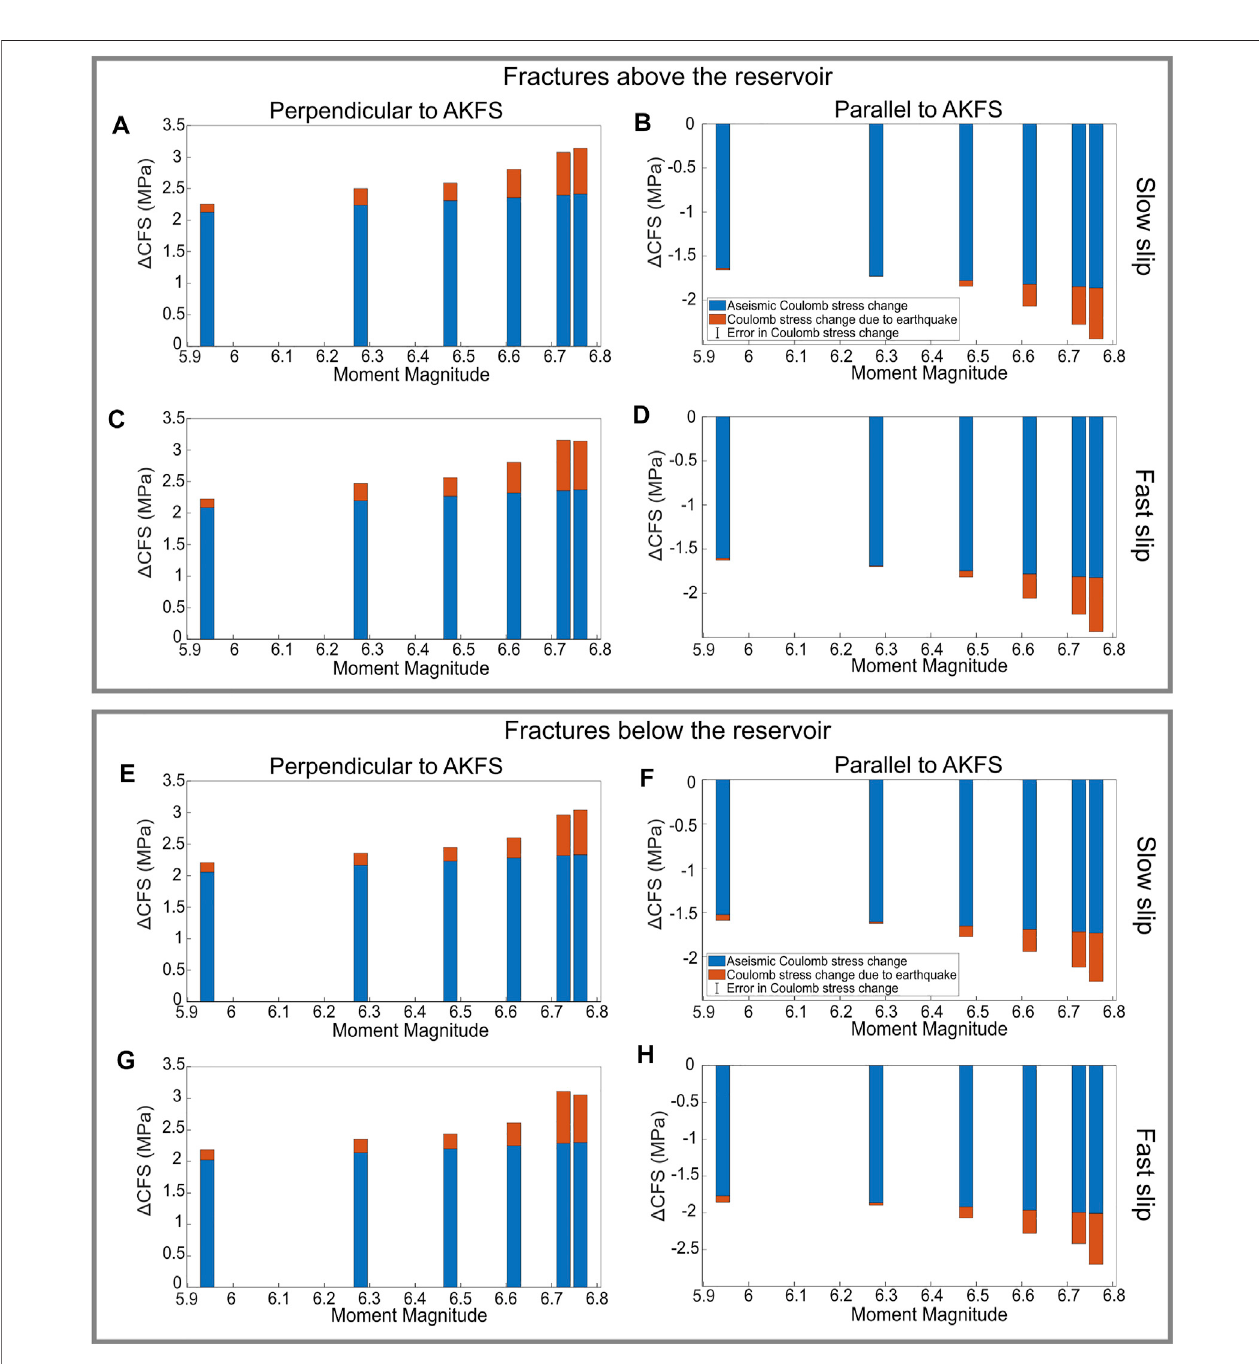
FIGURE4| BargraphsofmodeledchangesinCoulombfailurestressonverticalfracturesabove (A – D) andbelow (E – H) HasanDa ğ ’ smagmareservoir(extending from and to point probes a and b, respectively, in Figure 2B ). The blue bars represent the change in Coulomb failure stress due to gradual slip along the Akhisar-Kiliçc fault segment (AKFS) since its most recent rupture (5450 ± 160 ka) and prior to hypothetical earthquakes with given moment magnitude (M w ). Orange segments show the Coulomb failure stress change as a result of the hypothetical earthquakes. (A,B,E,F) show results for a rate of 0.58 mm yr − 1 right-lateral slip and a rate of 0.0536 mm yr − 1 ofnormal slipon the fault segment (labeled slow slip), while (C,D,G,H) show Coulomb failurestress change due toright-lateral slip of3.35 mm y − 1 and 0.0536 mm yr − 1 ofnormal slip(labeledfastslip). Positivestresschangesrepresent unclampingoffractures,whilenegative stresschangesindicateclamping. (A,C,E,G) show stress changes perpendicular to the strike of the AKFS. (B,D,F,H) show stress changes in a direction that is parallel to the strike of the AKFS.